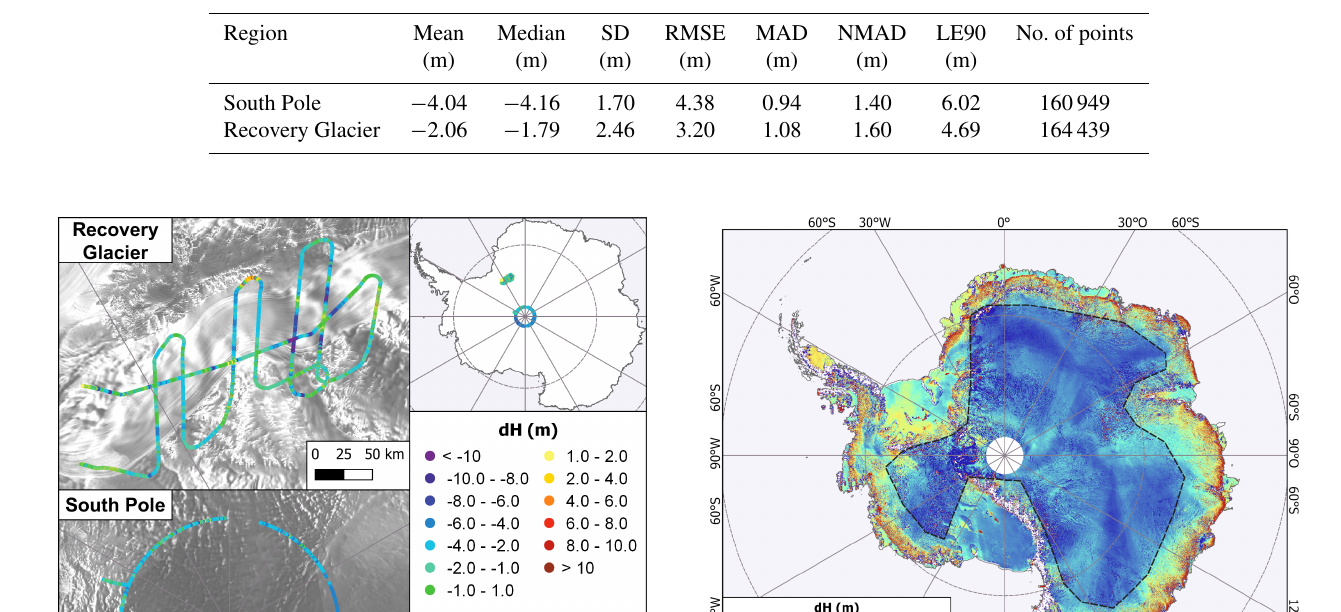
Table 3. Accuracy numbers for height differences of TanDEM-X minus IceBridge for October 2014 campaign.